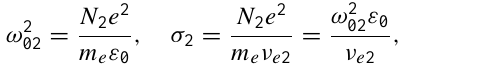
Fig. 2. Natural stabilization of stacked spectral estimates at first three Schumann Resonance (SR) modes for magnetic field ( H x ) component in the Garhwal Himalayan region. The horizontal axis represents the frequency and vertical axis, the amplitude, in shifted arbitrary scale for a different number of stacked segment